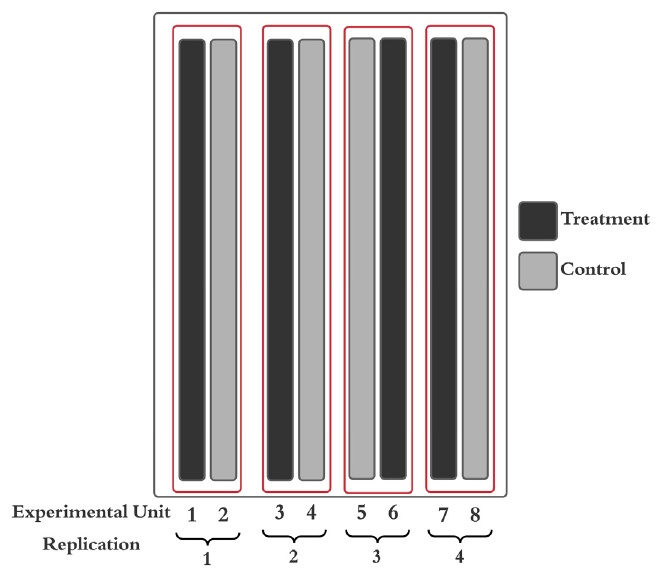
Figure 1. An example of a randomized compete block design (RCBD) to evaluate if a treatment impacted outcomes, such as yield. In this example there is one control and one treatment strip per block (replication), and the trial is replicated four times. When farm equipment permits, strips serve as experimental units (EUs), which typically cover the length of a field [10].